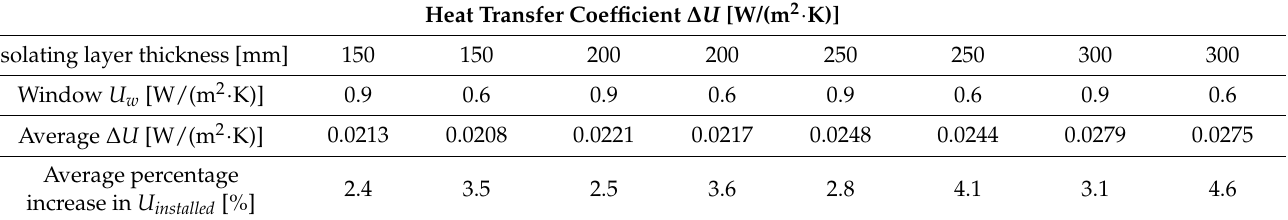
Table 1. Results of efficiency